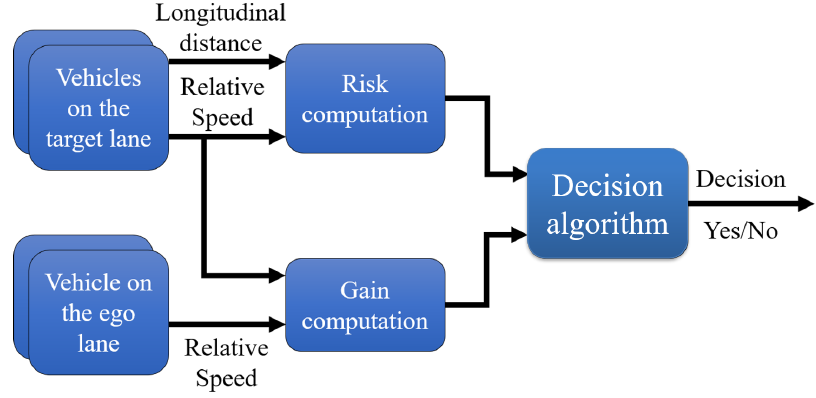
Figure 7. Diagram of the decision